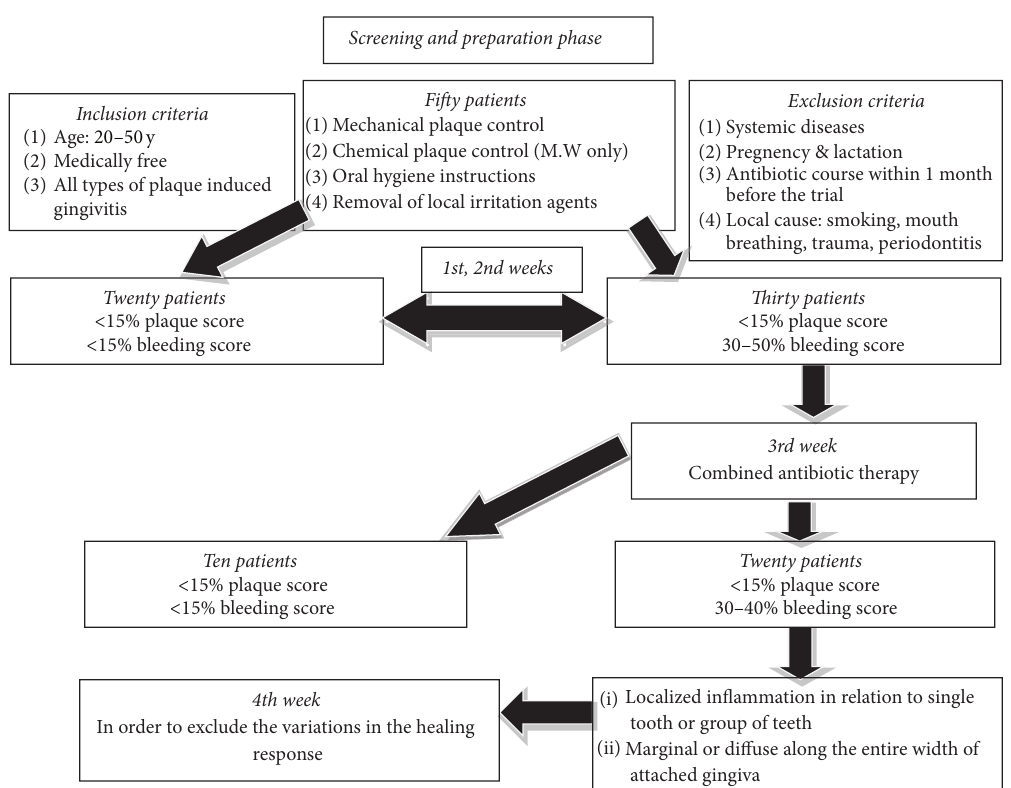
Figure 2: Scheme represents the procedure